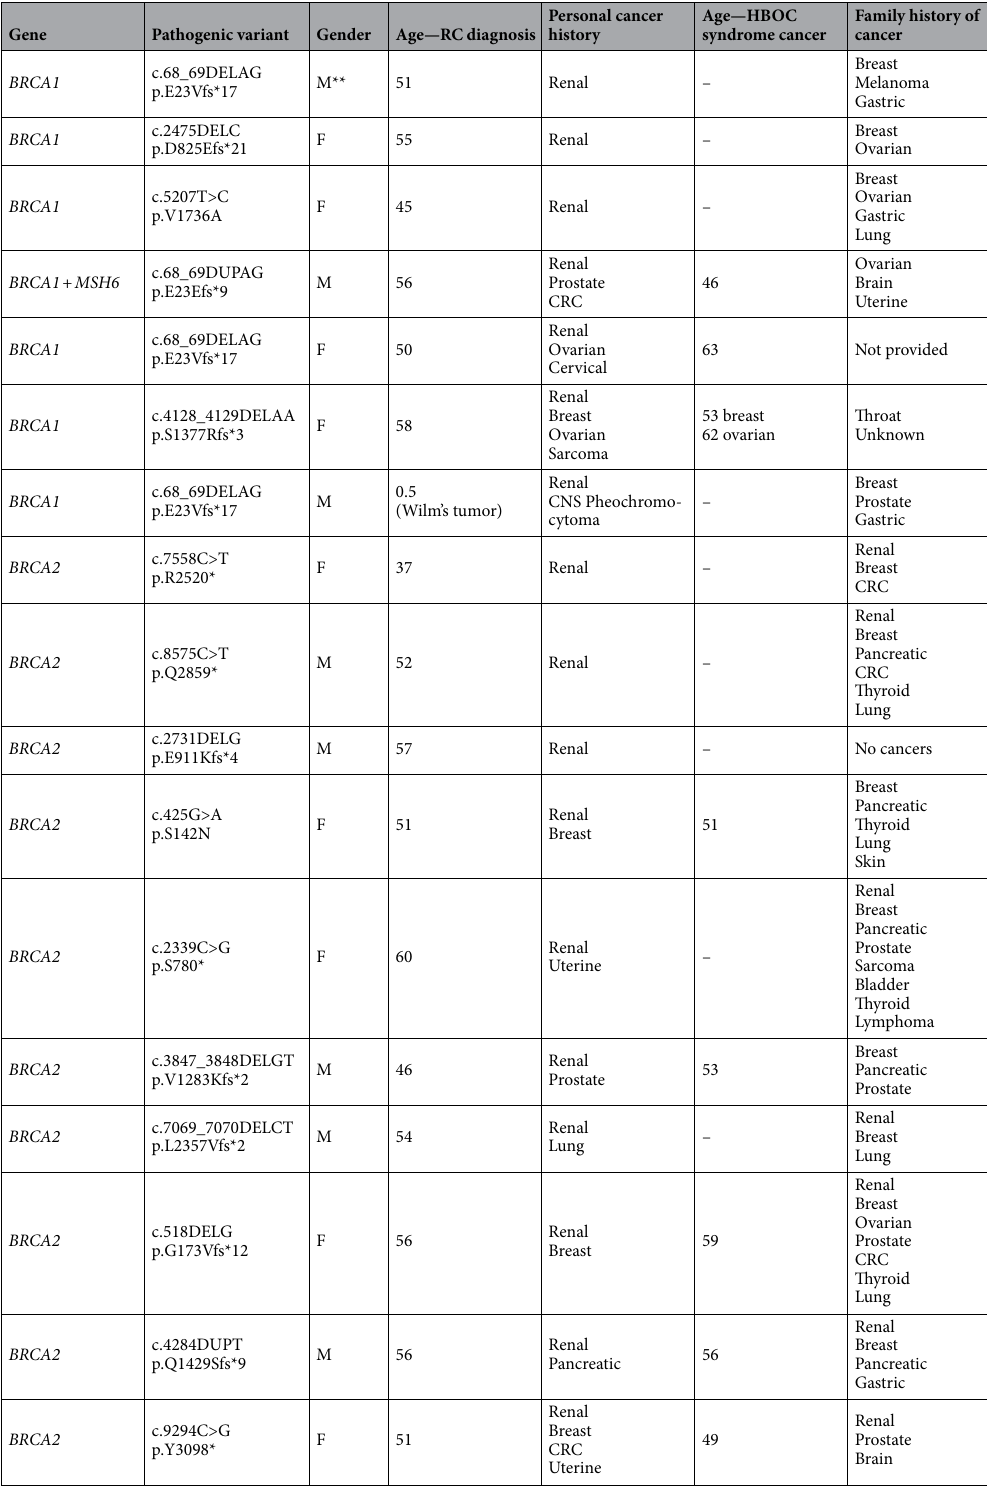
Table 2. Personal and family history of BRCA1 or BRCA2 positive patients in Ambry Genetics RC study cohort. Patient demographics, age of diagnosis, and cancer histories are listed. Family cancer histories listed for those who reported a family history. CNS central nervous system, CRC colorectal cancer, HBOC syndrome hereditary breast ovarian cancer syndrome, RC renal cancer, fs frame shift, **Ashkenazi Jewish. Family histories as self-reported on the intake form/medical records and have not been